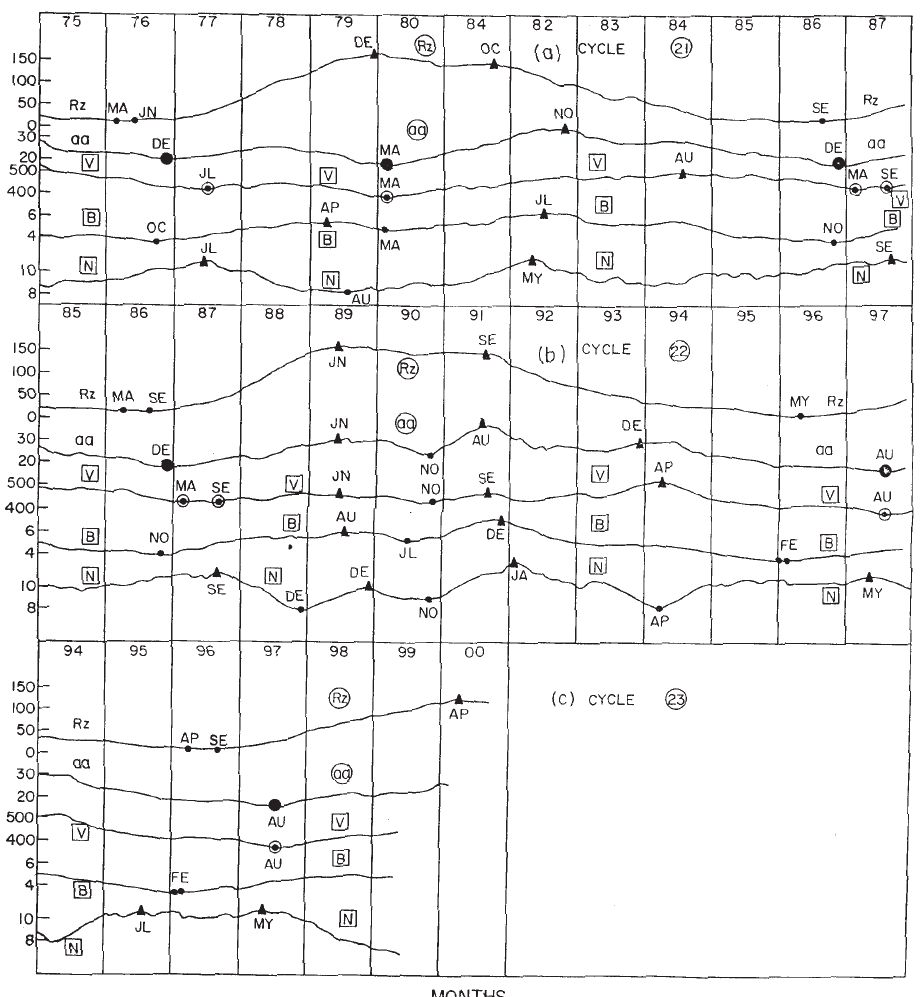
Fig. 3. Plots of the 12-month moving averages of Rz , aa , and solar wind parameters V , B , N , for (a) cycle 21 (1975–1987), (b) cycle 22 (1985–1997), (c) cycle 23 (1994–2000). The minima are indicated by full dots (big full dot for aa (min), open circle for V (min)) and maxima by full